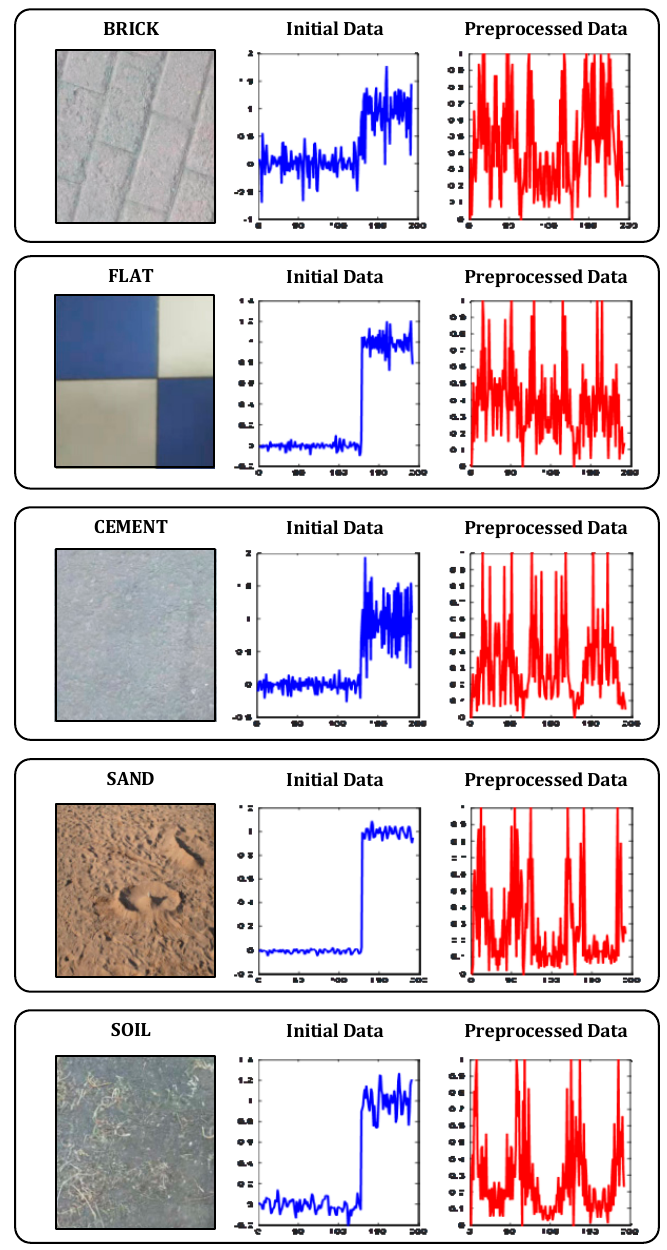
Figure 3. Data acquisition results.